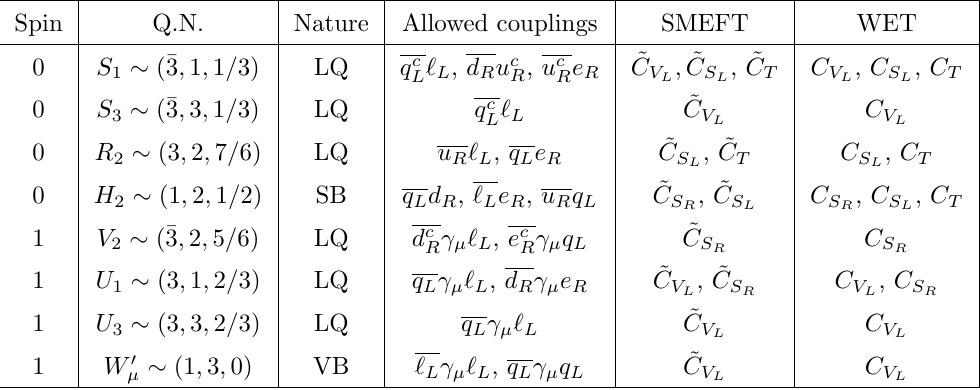
Table 5 . Spin, SU(3) C (cid:10) SU(2) L (cid:10) U(1) Y quantum numbers, nature (LQ = leptoquarks, SB = scalar boson and VB = vector boson) and allowed interactions of the possible candidates to mediate b c transitions. In our notation, (cid:9) c ((cid:9) L ) c L (cid:17) !